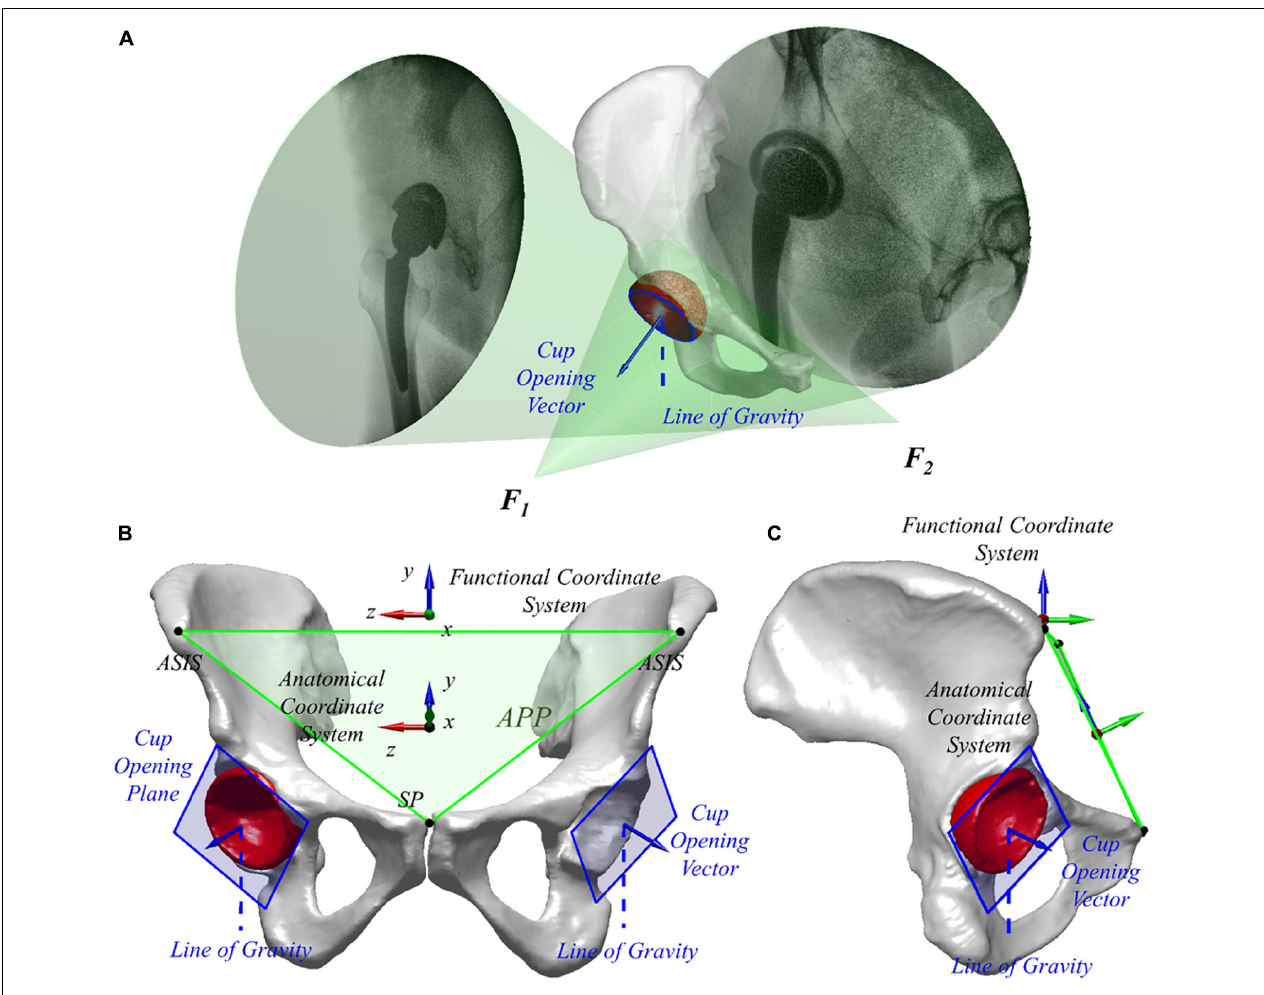
FIGURE 1 | (A) Virtual environment of dual fluoroscopic imaging system (DFIS) with the line of gravity is shown. (B,C) Three-dimensional surface model of the pelvis and total hip arthroplasty (THA) acetabular implant in different views. The anterior pelvic plane (APP) and anatomical and functional coordinate systems are